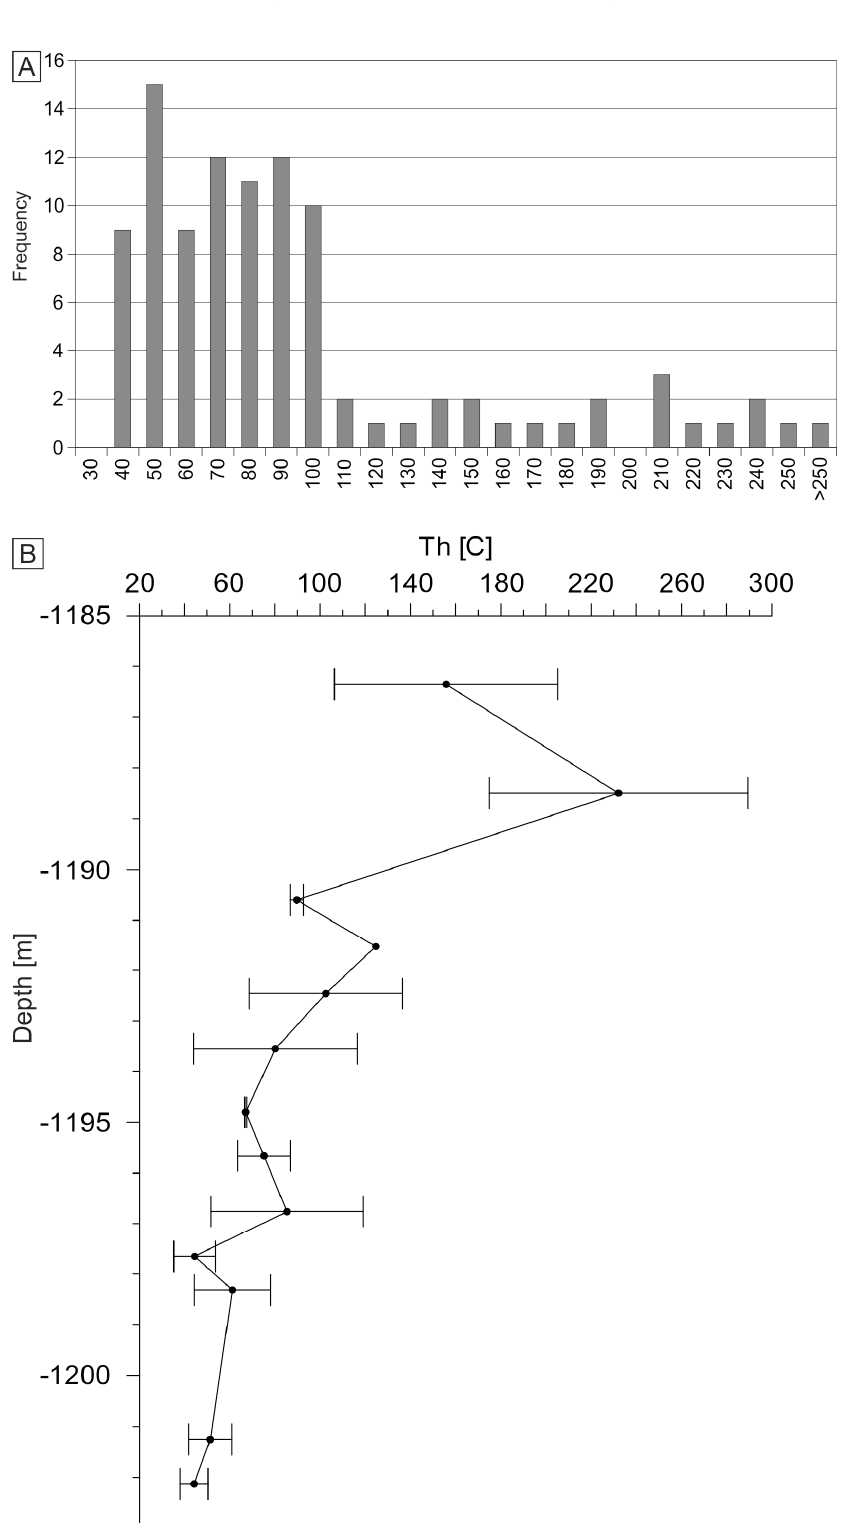
Figure 8. ( A ) Histogram of homogenization temperatures. ( B ) Distribution of mean homogenization temperatures in the samples (the horizontal line represents standard deviation).